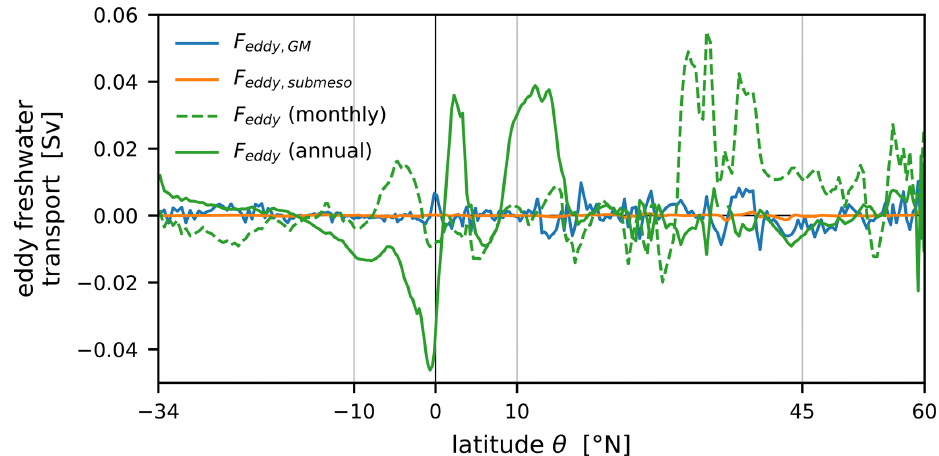
Figure B2. Freshwater transport terms calculated from the eddy salt advection terms diagnosed by the LR-CESM model compared to the monthly and annual F eddy term (green) which are shown in Figs. 7b and B1. The model diagnoses salt advection by the GM parameterization (blue) and the submesoscale mixing parameterization